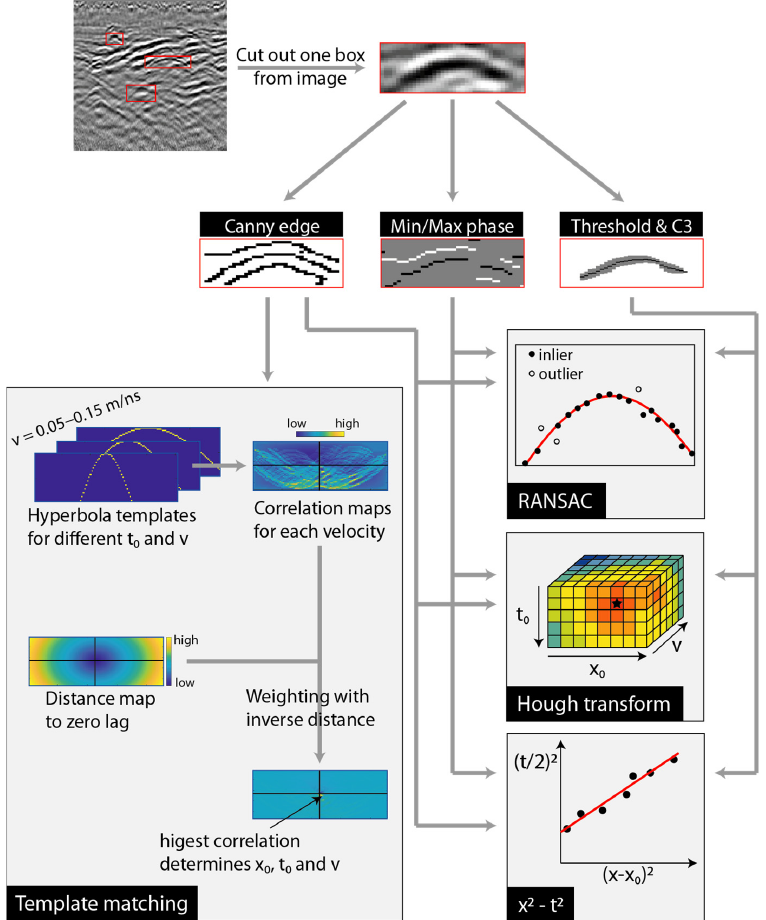
Figure 2. Flowchart showing the connections between methods: three different algorithms for hyperbola point extraction are applied on the detected box (Canny edge, Min/Max phase, and Threshold and C3). The Canny edge image is fed into the template matching as well as into the other fitting routines (RANSAC, Hough transform and x 2 − t 2 ), whereas Min/Max phase and Threshold and C3 are only fed into RANSAC, Hough transform, and x 2 − t 2 fitting. This results in 10 different values for x 0 , t 0 , and v for one detected box.